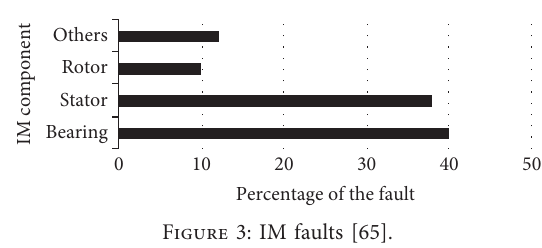
Figure 3: IM faults